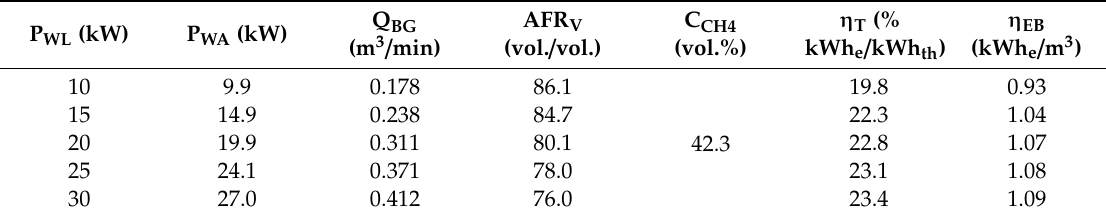
Table 2. Characteristics of micro gas turbine electricity generator at di ff erent rated power loads (test operation).